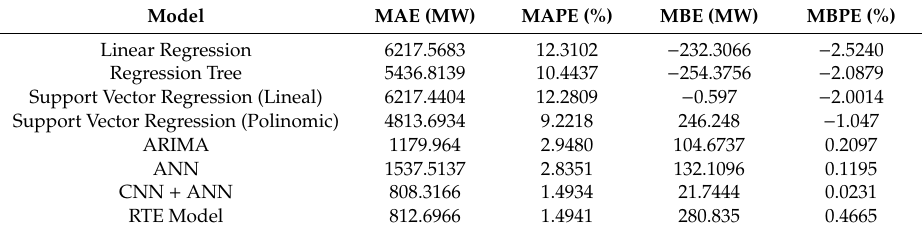
Table 5. Comparison between the proposed solution and the existing